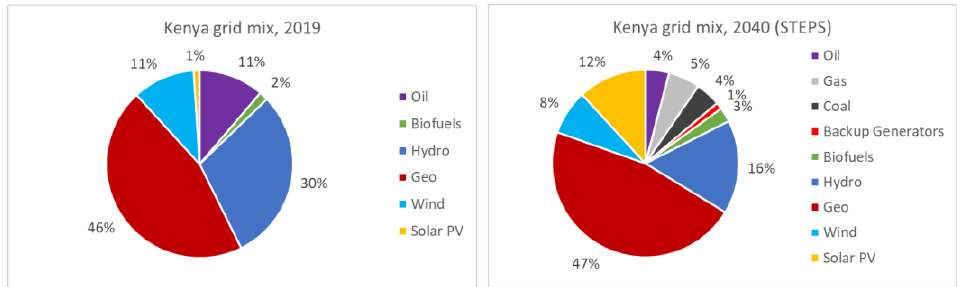
Figure 3. Current [58] and future electricity grid mix compositions for Kenya, with the latter based on IEA “STEPS” scenarios [58]. Note: Numbers may not add up to 100% due to rounding.